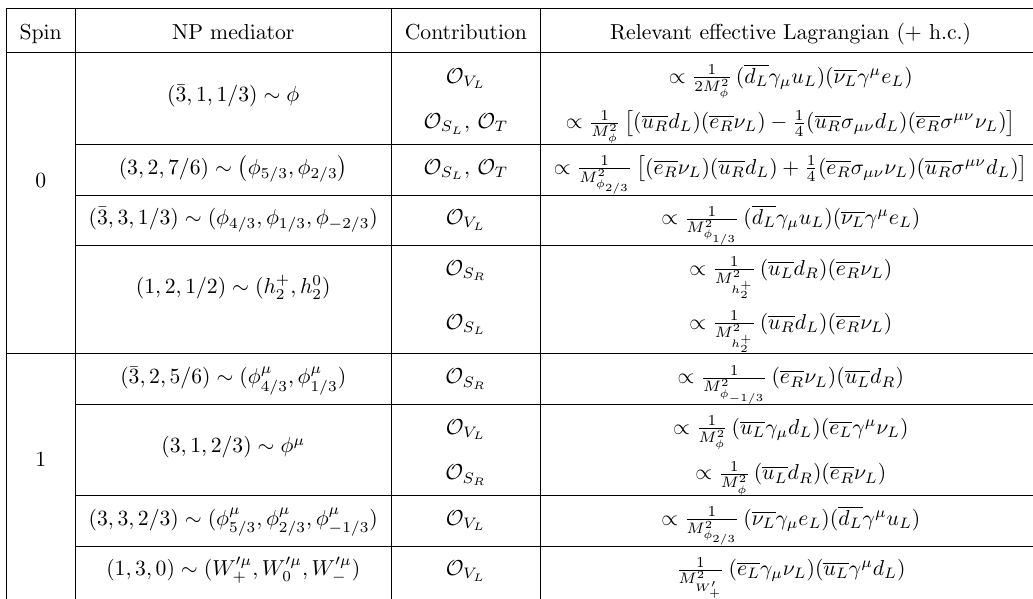
Table 12 . Possible (cid:12)elds contributing to the e(cid:11)ective Hamiltonian of eq. (4.1), at dimension 6: leptoquarks are denoted by (cid:30) and a second Higgs doublet as h 2 . Their quantum numbers (SU(3), SU(2), U(1) Y ), contribution to the EFT operators and their relevant e(cid:11)ective Lagrangian after integrating them out are described for each new (cid:12)eld. Their SU(2) decomposition is explicitly shown after the \ (cid:24)